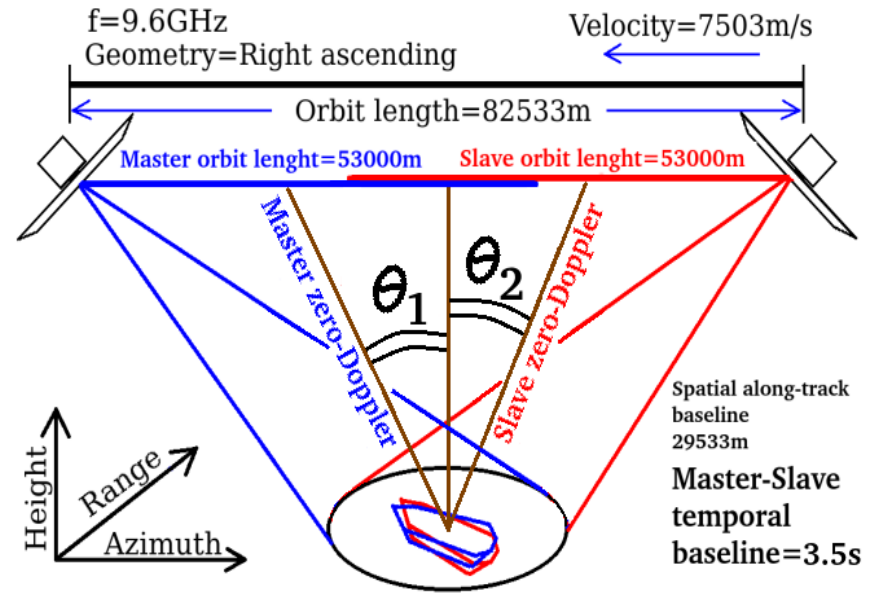
Figure 1. SAR acquisition